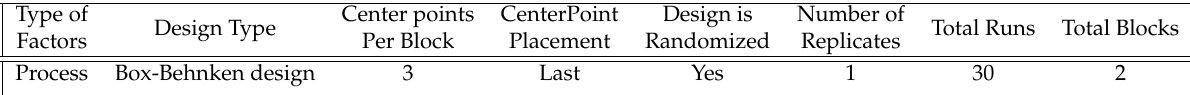
Table 3. Design of experiments for a gas metal arc welding